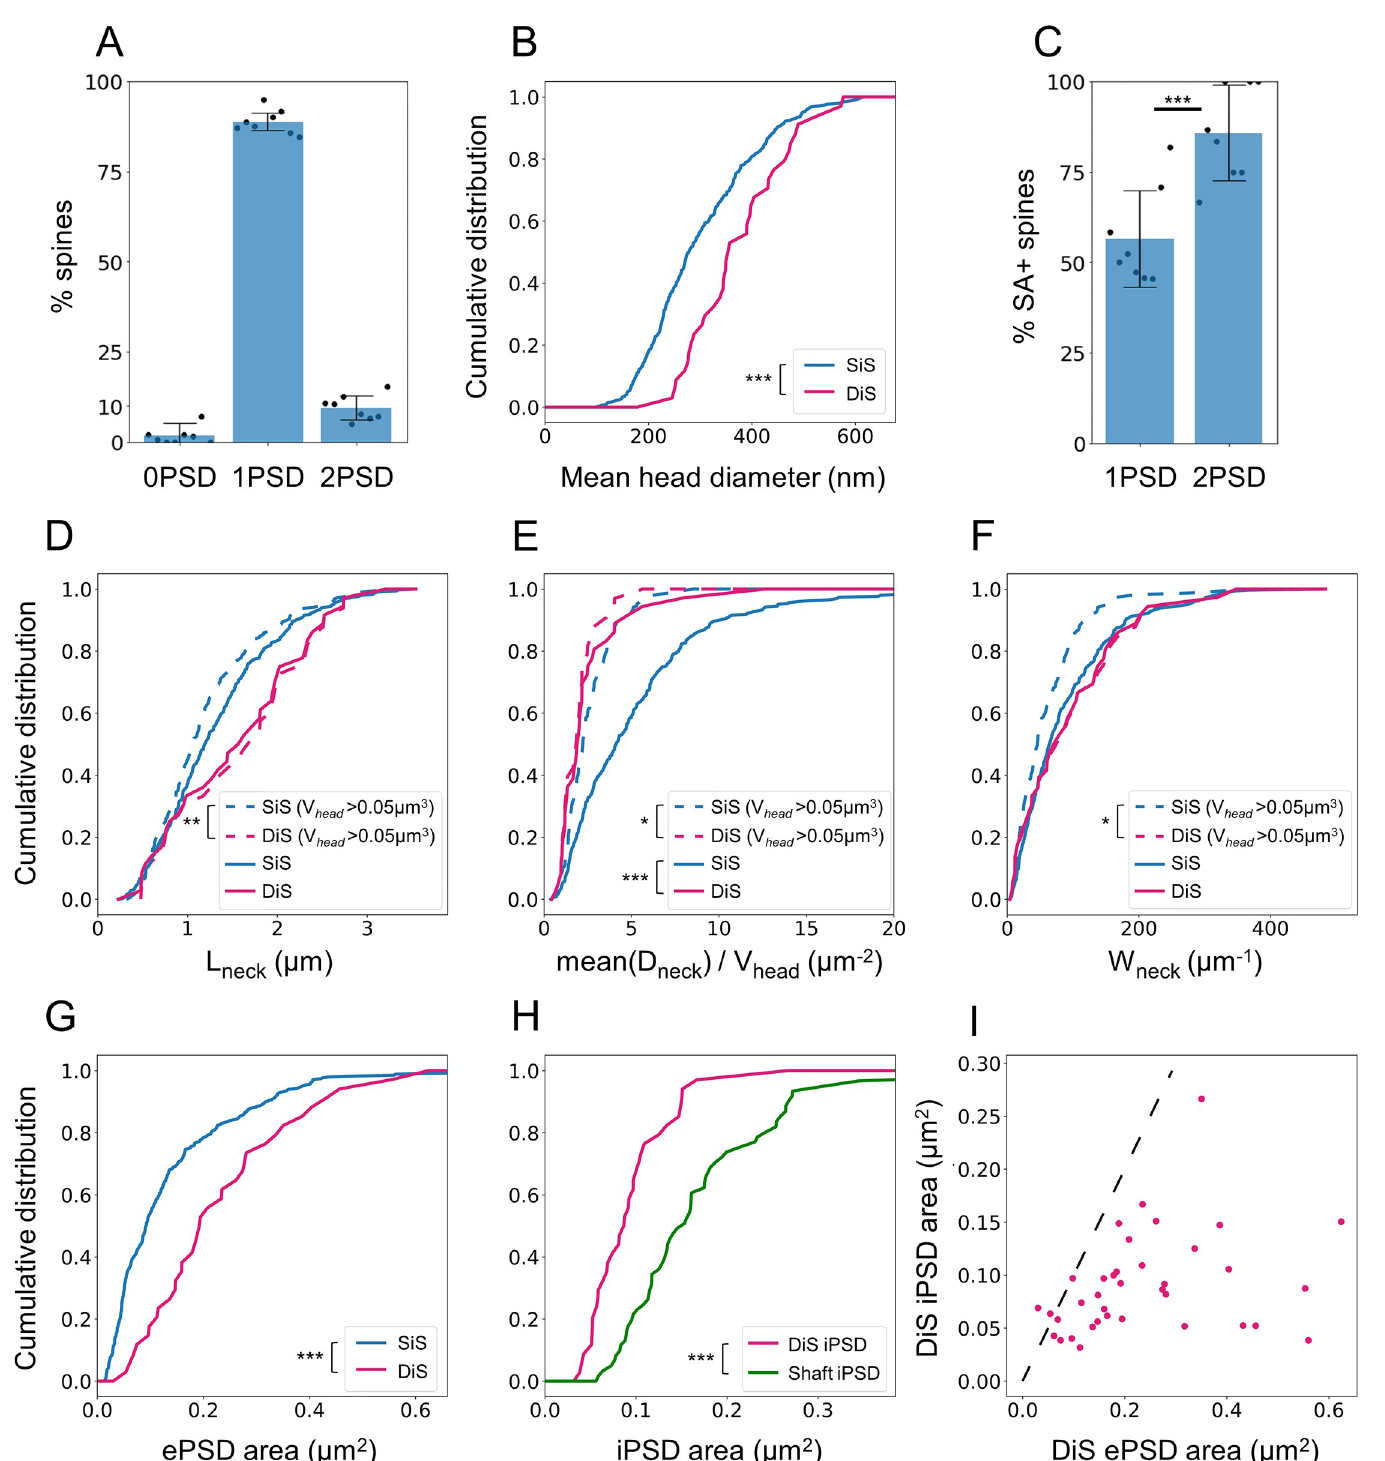
Fig 5. DiSs have unique anatomical properties. (A) Proportion of spines harboring 0, 1, or 2 synaptic contacts, quantified with CLEM. Histograms represent mean ± SD, from 390 spines in N = 8 dendrites. (B) Quantification of mean spine head diameter for SiSs (blue) and DiSs (red) ( p < 10 − 4 ). (C) Proportion of SiSs and DiSs harboring an SA ( p < 10 − 10 using Pearson χ 2 test). (D-F) Quantification of neck length (D), the ratio between mean neck diameter and head volume (E), and the diffusional neck resistance (W neck ) (F) between SiSs and DiSs (solid lines, N = 349 and 37, respectively) and between DiSs with SiSs of similar head volume (spines with V head > 0.05 μ m 3 , dashed lines, N = 186 and 34, respectively). (G) Quantification of ePSD area in SiSs or DiSs ( p < 10 − 5 ). (H) Quantification of iPSD area in DiSs and